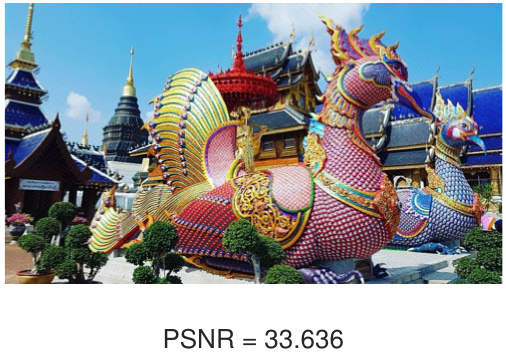
Figure 29. The reconstructed RGB image from the blurring operators A 1 , A 2 , and A 3 using the proposed algorithm presented in 10,000 iterations, respectively.